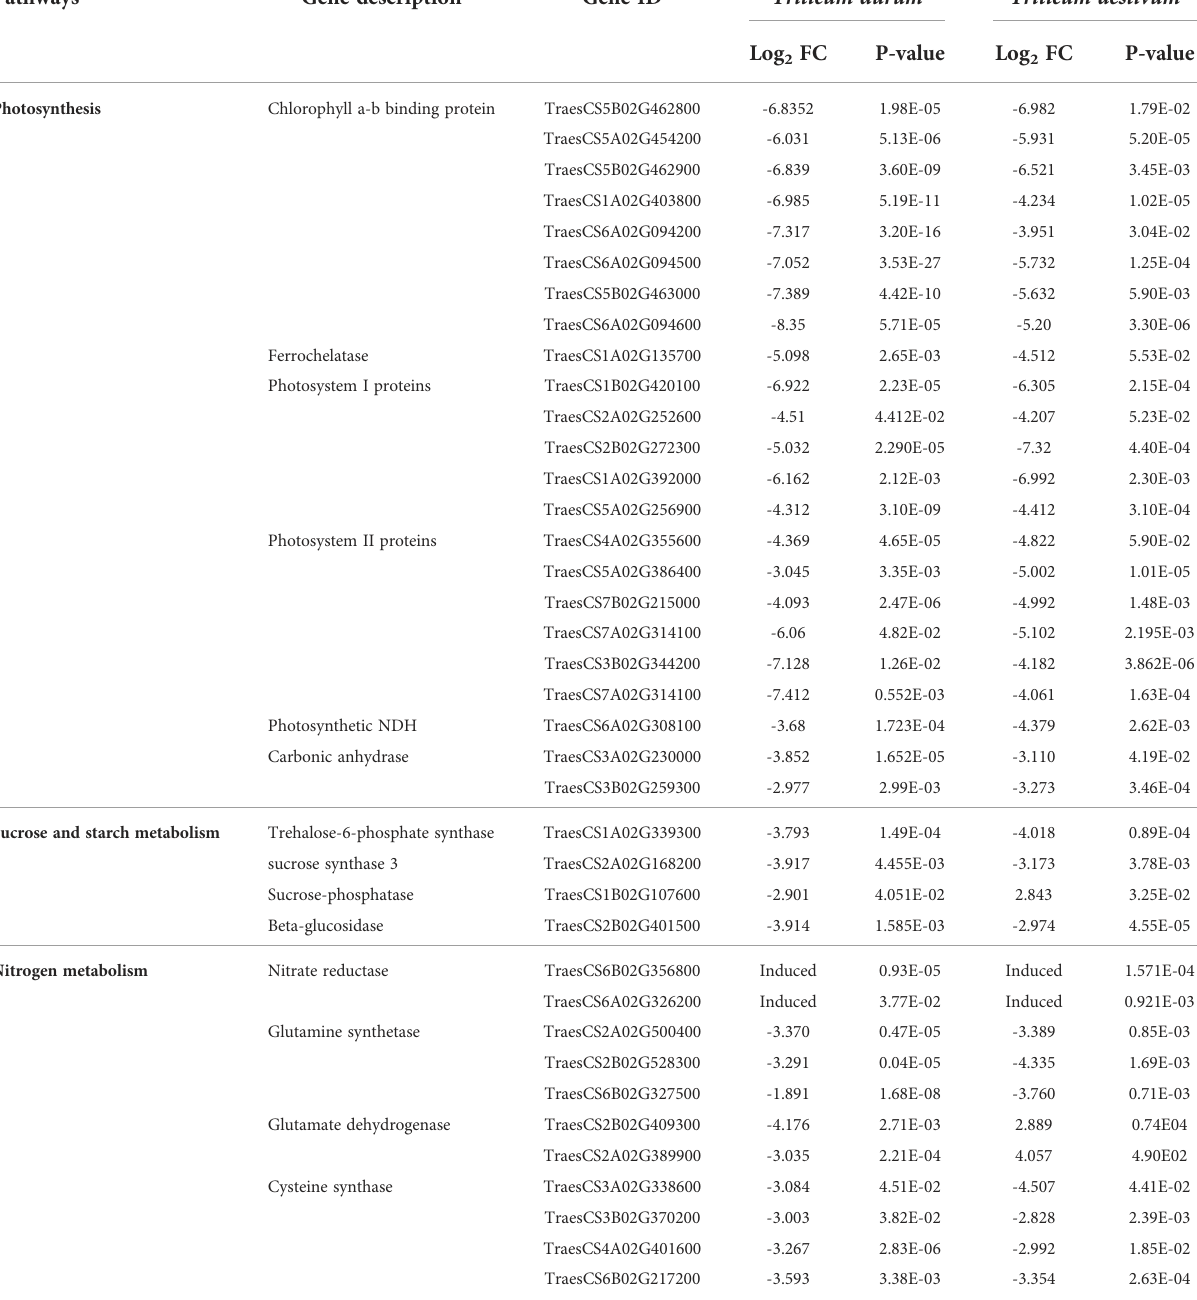
TABLE 4 Differentially expressed genes (DEGs) associated with primary plant metabolism.